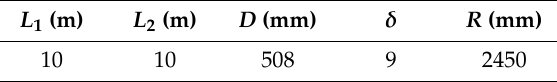
Table 1. Parameters of the geometrical